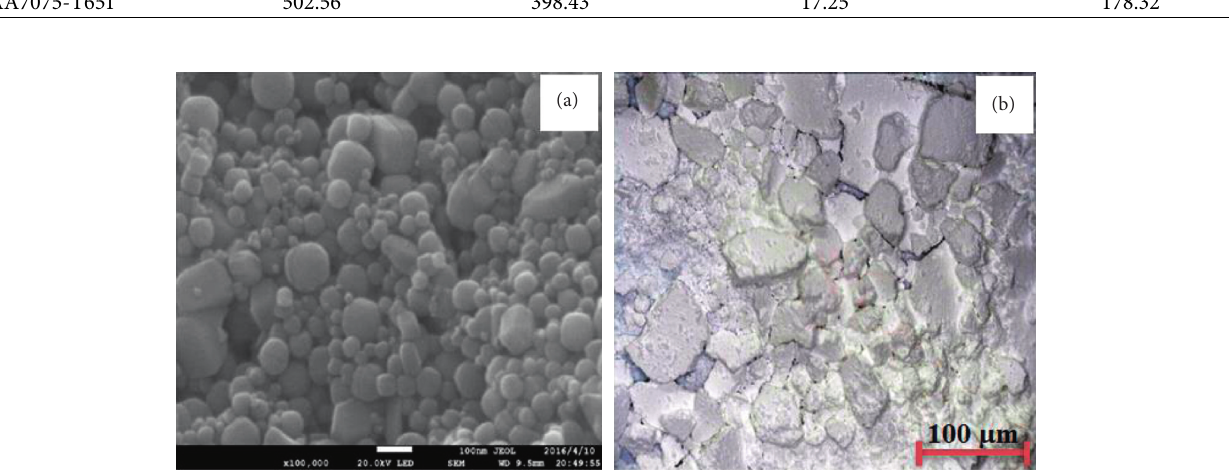
Figure 1: (a) SEM and (b) optical macroimage of h-BN. Table 3: Chemical constituents of reinforcing material.